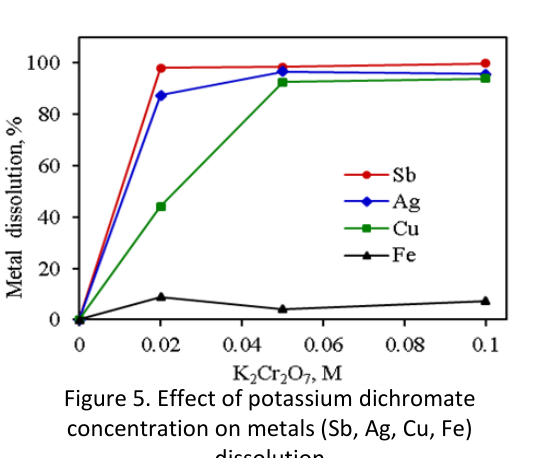
Figure 5. Effect of potassium dichromate concentration on metals (Sb, Ag, Cu, Fe)